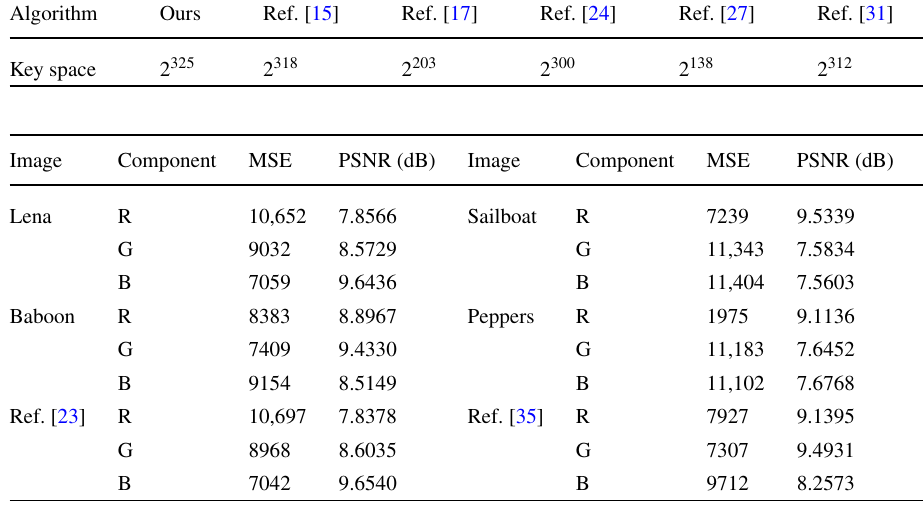
Table 2 Comparison of key space with other algorithms Algorithm